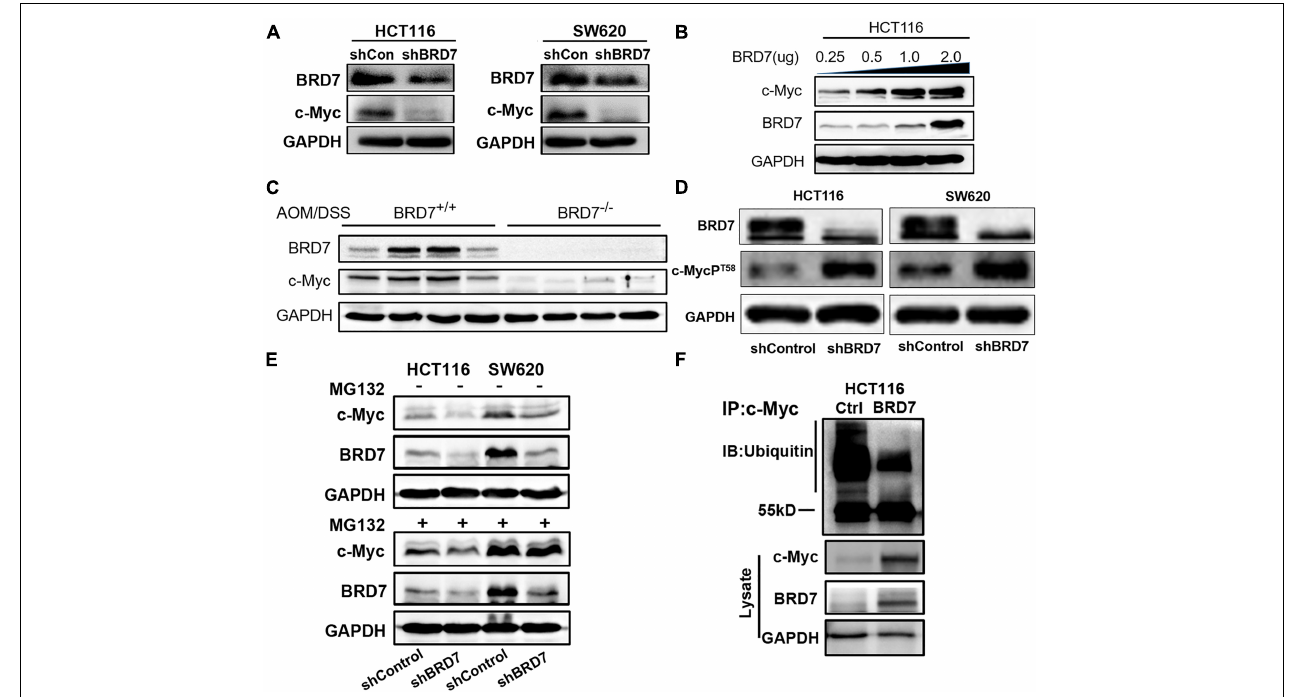
FIGURE 3 | BRD7 enhances the stability of the c-Myc protein by inhibiting its ubiquitination. (A) Western blot analysis detected the effect of BRD7 knockdown on c-Myc protein expression in HCT116 and SW620 cell lines. (B) The effect of BRD7 overexpression on c-Myc protein in HCT116 cells at different doses. (C) The expression of BRD7 and c-Myc protein in the colorectal tissues of azoxymethane/dextran sodium sulfate (AOM/DSS)-induced colorectal cancer (CRC) mice ( N = 4). (D) Western blot analysis showed the effect of BRD7 knockdown on the phosphorylation levels of c-Myc protein at T58 sites in both HCT116 and SW620 cells. (E) Western blot analysis showed the effect of BRD7 knockdown on ubiquitin–proteasome-mediated protein stability of c-Myc in MG132-treated HCT116 and SW620 cells. MG132, proteasome inhibitor MG132. (F) Immunoprecipitation (IP) and western blot assays confirmed the effect of BRD7 on the ubiquitination of c-Myc